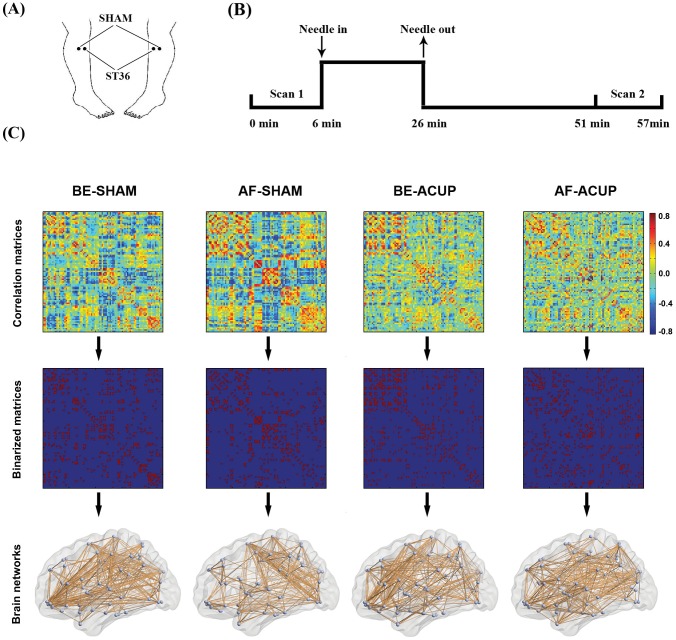
A schematic illustration of the design paradigm and brain network construction.(A), The points of stimulation used in the present study: verum acupuncture at ST36 (ACUP) and sham points (SHAM); (B), Two scans were performed before and after the stimulation at both ACUP and SHAM, which were used to construct brain networks, respectively. (C) Top, under each condition, a correlation matrix was obtained for each subject by calculating inter-regional Pearson correlation coefficient of mean time series among 90 regions; Middle, these correlation matrices were further converted into binary versions (i.e., adjacency matrices) by applying a thresholding procedure such that the elements were set to 1 if their absolute correlation coefficients were larger than a predefined threshold and 0 otherwise; Bottom, the obtained binary matrices could be finally represented as networks or graphs that were composed of brain nodes and edges.